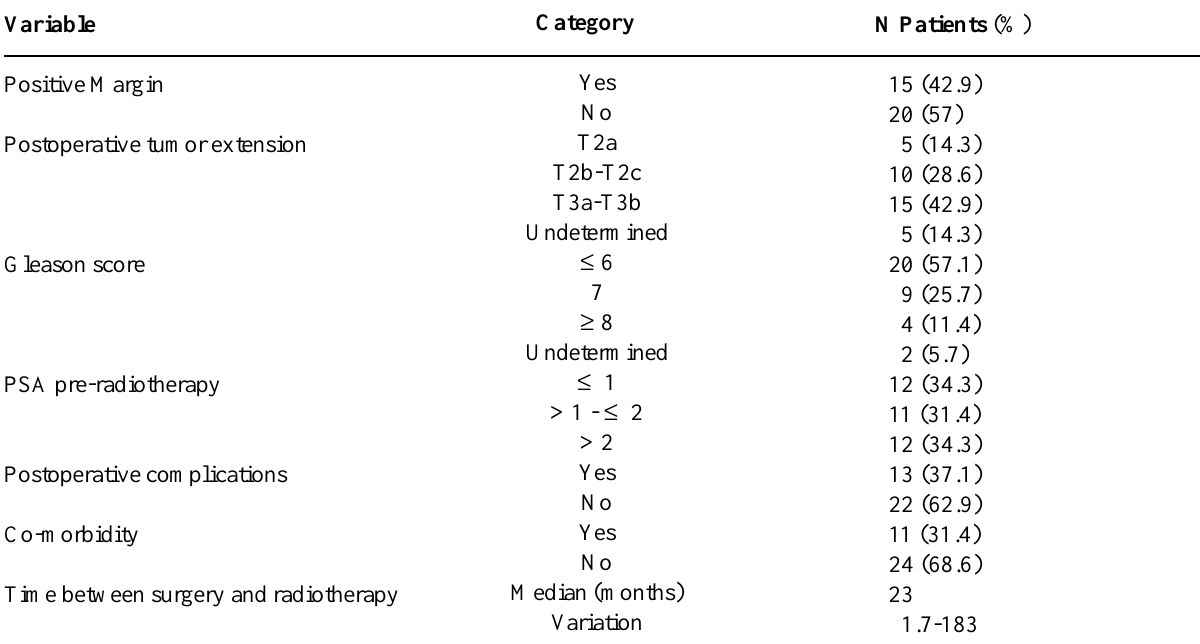
Table 1 – Characteristics of patients submitted to salvage conformal radiotherapy in biochemical recurrence after radi- cal